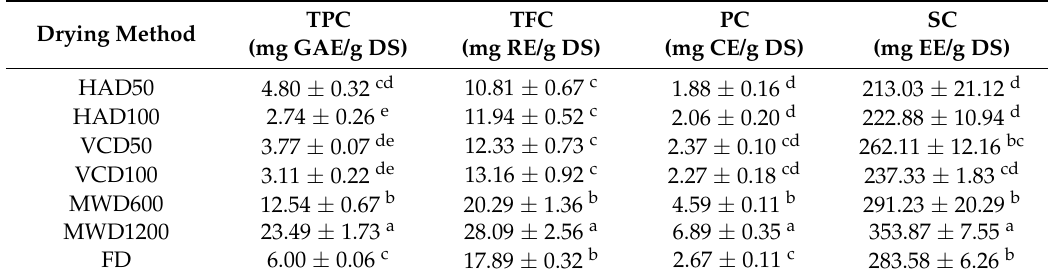
Table 2. Phytochemical compounds of carrot peel dried at various conditions ( n = 3). TPC Drying Method (mg GAE/g